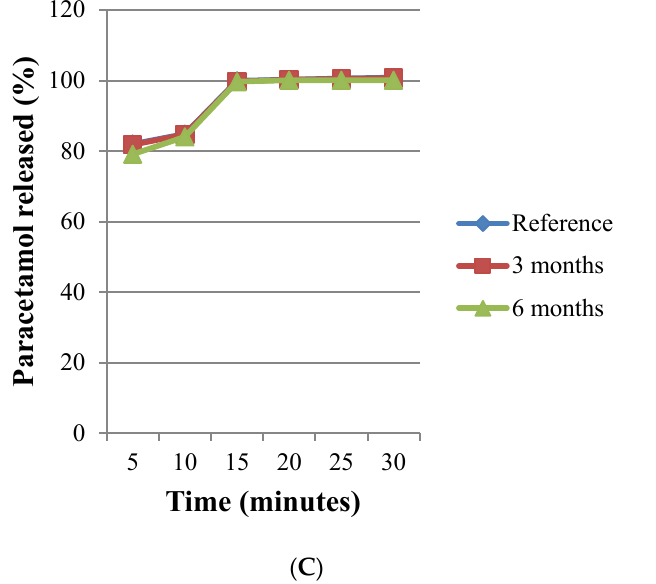
Figure 7. ( A ) Plot of percentage of paracetamol released over time for the dissolution test of each formulation; ( B ) Comparison of paracetamol released (%) between the reference, 3 months and 6 months of storage at conditions 40 ± 2 ° C/75 ± 5% RH for Formulation 4; ( C ) Comparison of paracetamol released (%) between the reference, 3 months and 6 months of storage at conditions 40 ± 2 ° C/75 ± 5% RH for Formulation 5. Note: n = 6 for all formulations.